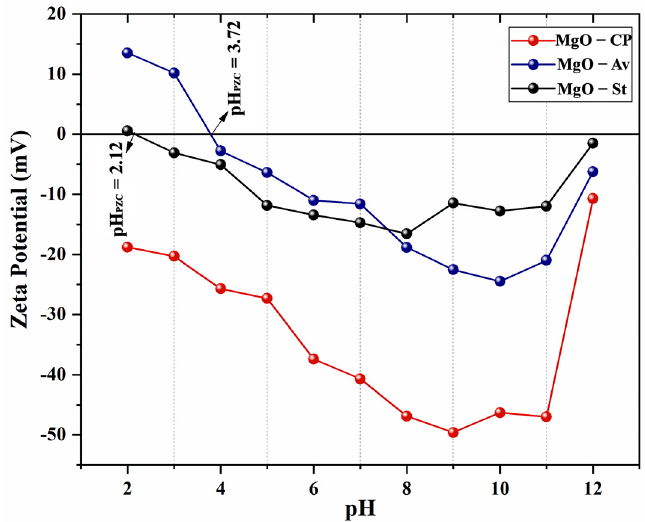
Figure 4. Zeta potential as a function of pH and point of zero charge (pH PZC ) for the MgO-St, MgO-CP, and MgO − Av samples.